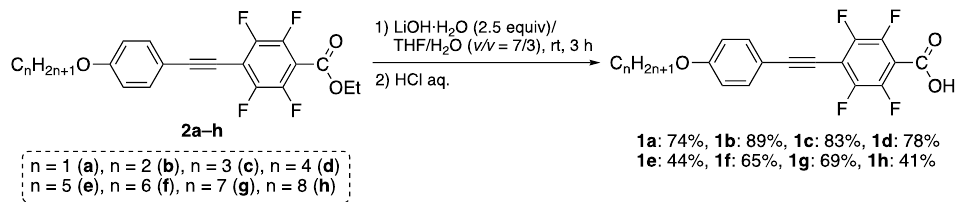
Figure 3. Synthetic procedure of 1a – h from the corresponding ester 2 .